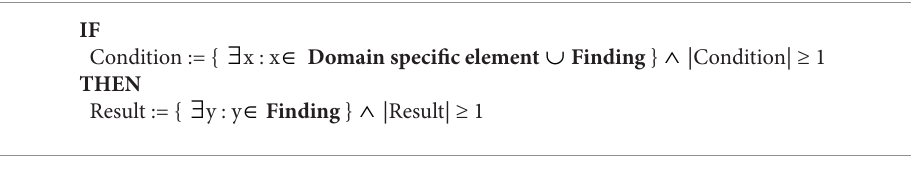
Fig. 4. BR template for general finding